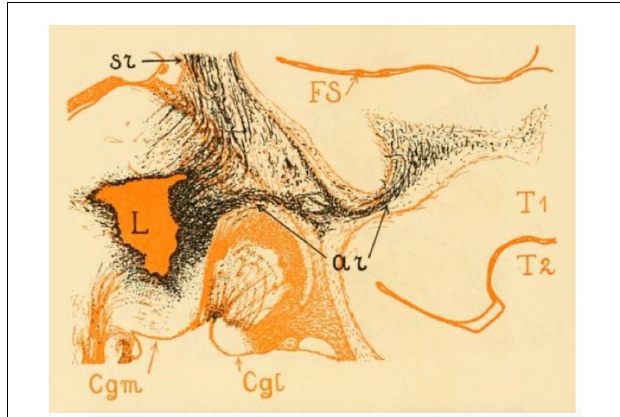
FIGURE 3 | (A) Schematic representation of the projection fibers of the human brain (coronal view). (B) Coronal cut through the middle section of the thalamus. (C) Axial section of the brain; cut through the inferior thalamus. In the three panels, fibers belonging to the acoustic radiation have been highlighted in green and fibers of the internal capsule in pink. The acoustic radiation projects from the thalamus (TH) to the first temporal circonvolution (T1) and passes through the sub-lenticular and posterior segment of the internal capsule. This map clearly highlights the crossing between these two fiber systems. CC, Corpus callosum; EC, external capsule; ICPL, Posterior limb of the internal capsule; ICSL, sub-lenticular part of the internal capsule; CR, corona radiata; LGN, lateral geniculate nucleus; MGN, medial geniculate nucleus; T1, first temporal circonvolution; TH, thalamus (adapted from Dejerine and Dejerine-Klumpke, 1895; https://archive.org, public